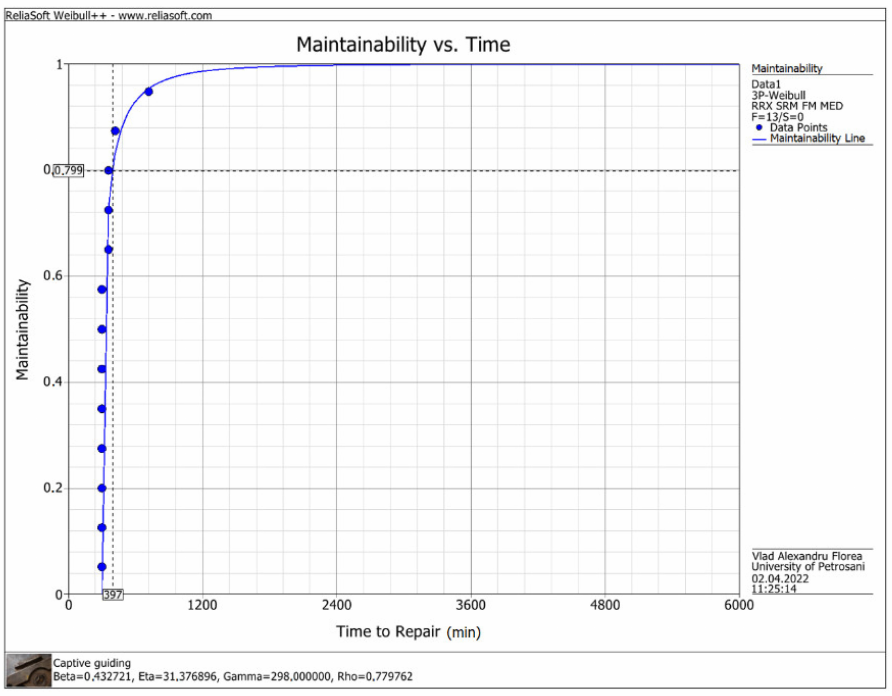
Figure 8. Cleat maintainability values for a 79,9% confidence level for the captive